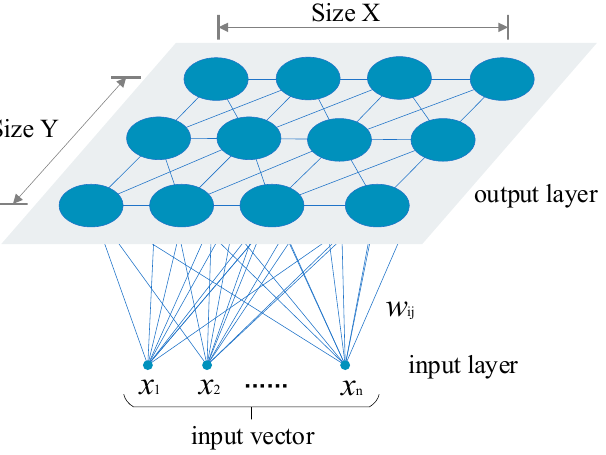
Figure 5. Topology of the SOM network.